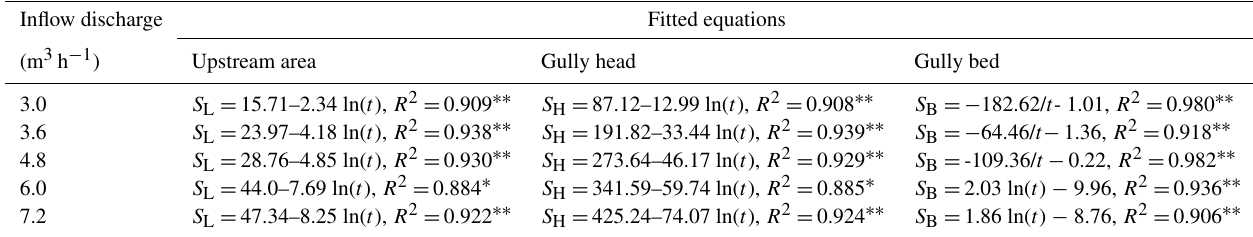
Table 3. Relationships between soil loss rate of three landform units and time. Inflow discharge Fitted equations